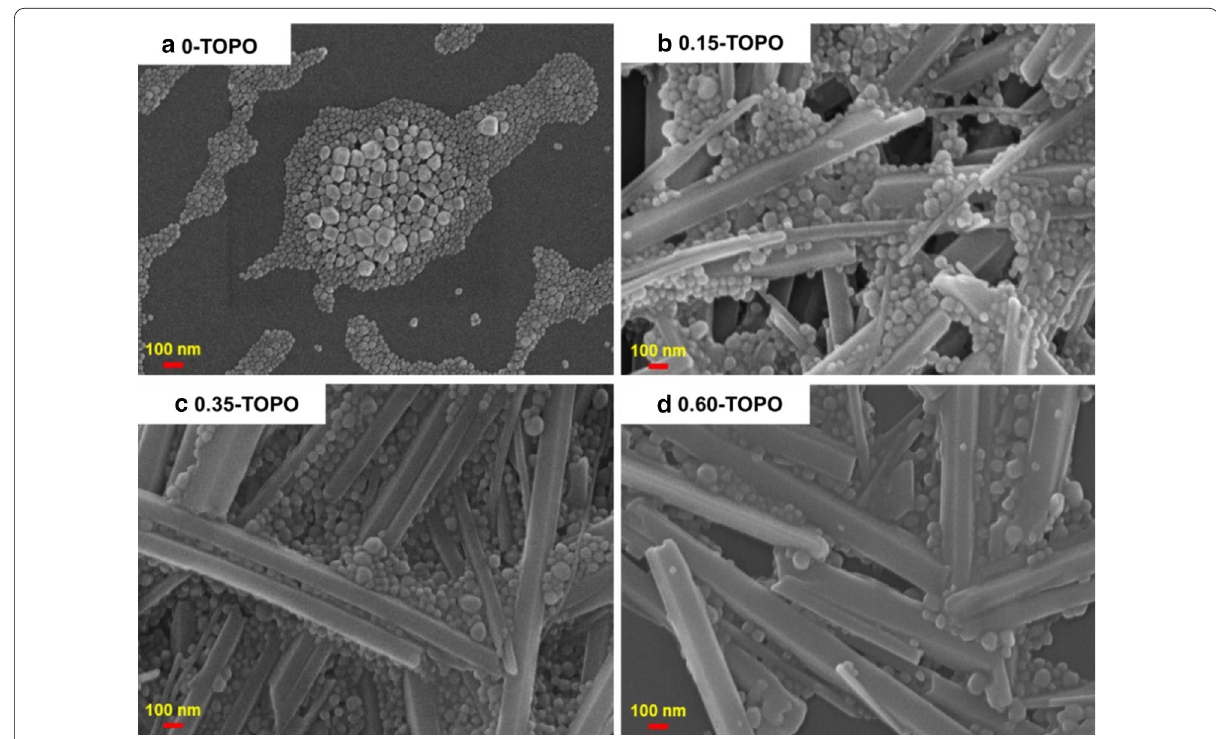
Fig. 4 Top view of SEM micrographs of CsPbI 3 /TOPO composite films with different ratios: a 1:0, b 1: 0.15, c 1:0.35, d